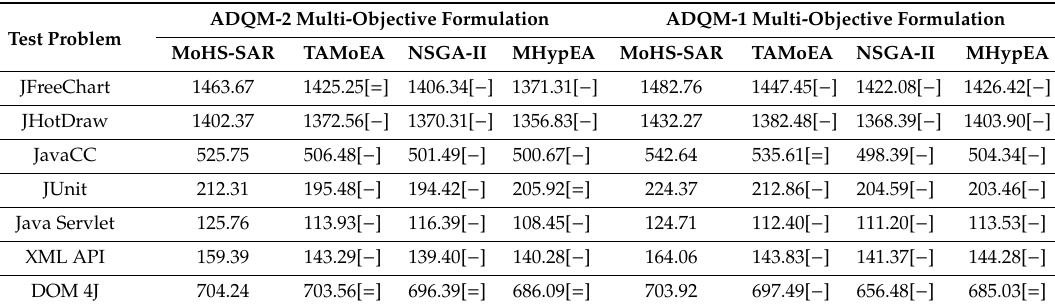
Table 6. Cohesion as an assessment criterion.